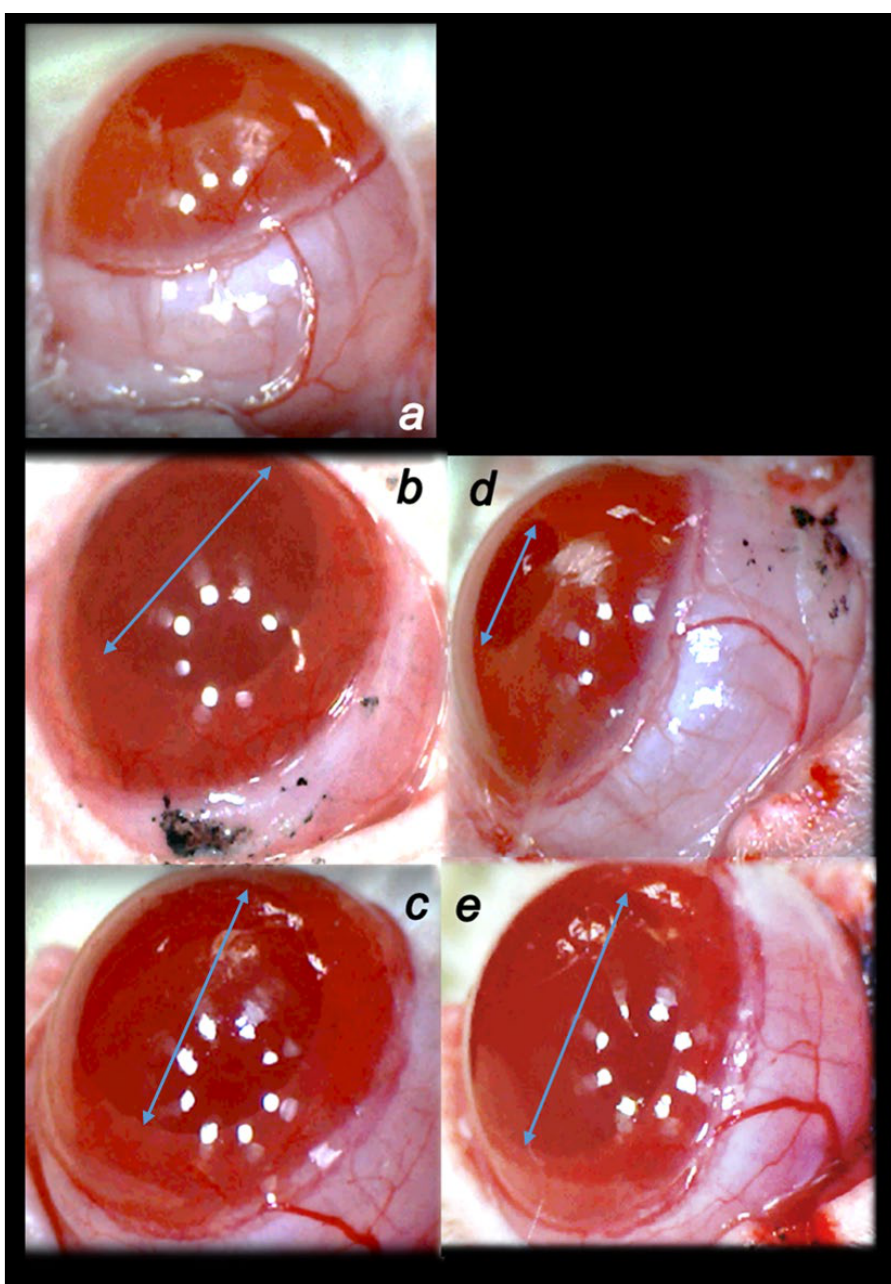
Figure 3. Illustrative presentation of the pupil changes. ( a ) Normal pupil presentation in healthy rats (( a ), white letter). ( b ) Persisting mydriasis (i.e., at 24 h post-injury) as effect of cauterization of the three episcleral veins. ( c ) Persisting mydriasis (i.e., at 24 h post-injury) as effect of cauterization of the three episcleral veins. ( d ) Counteraction of the previously persisting mydriasis (i.e., throughout 24 h post-injury) as effect of cauterization of the three episcleral veins upon BPC 157 therapy. ( e ) Upon distilled water eye therapy, unchanged presentation of continuously persisting mydriasis (i.e., throughout 24 h post-injury) as effect of cauterization of the three episcleral veins. Regular effect of cauterization of the three episcleral veins (( b , c ) , black letters), persisting mydriasis, illustration at 24 h post-injury (arrows), and effect of therapy application, BPC 157 (mydriasis counteraction) (( d ), black letter) (( b ) → ( d )) or distilled water eye drops (( c ), black letter) (persisted mydriasis) (( c ) → ( e )) (at 1 min after therapy). A similar effect was noted with all BPC 157 regimens. USB microscope camera Veho Discovery VMS-004 Deluxe. A total of 6